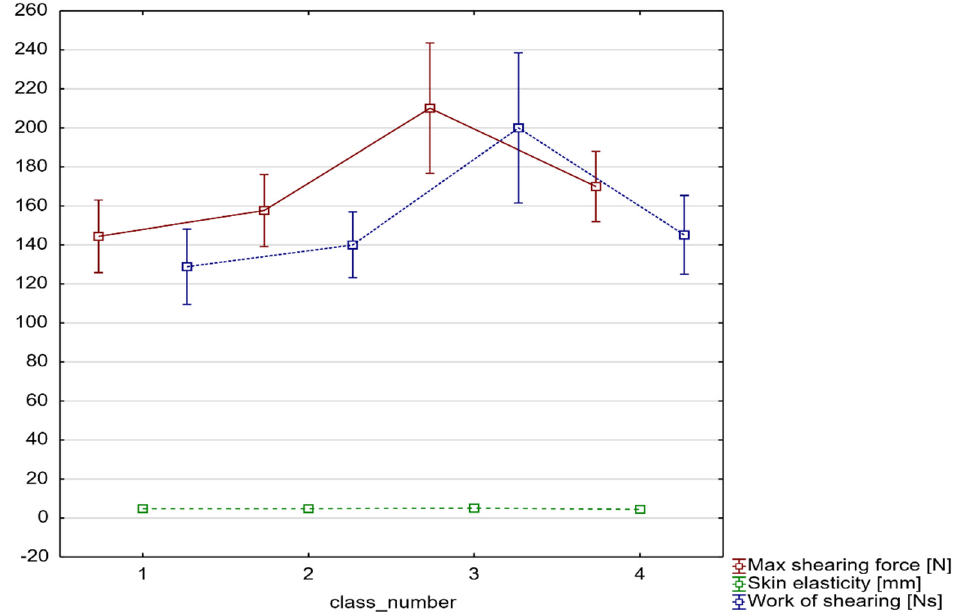
Figure 2. Average values of shearing force, skin elasticity, and work of shearing for samples belonging to classes 1–4, which corresponded to drying temperatures of 60, 70, 80, and 90 °C.